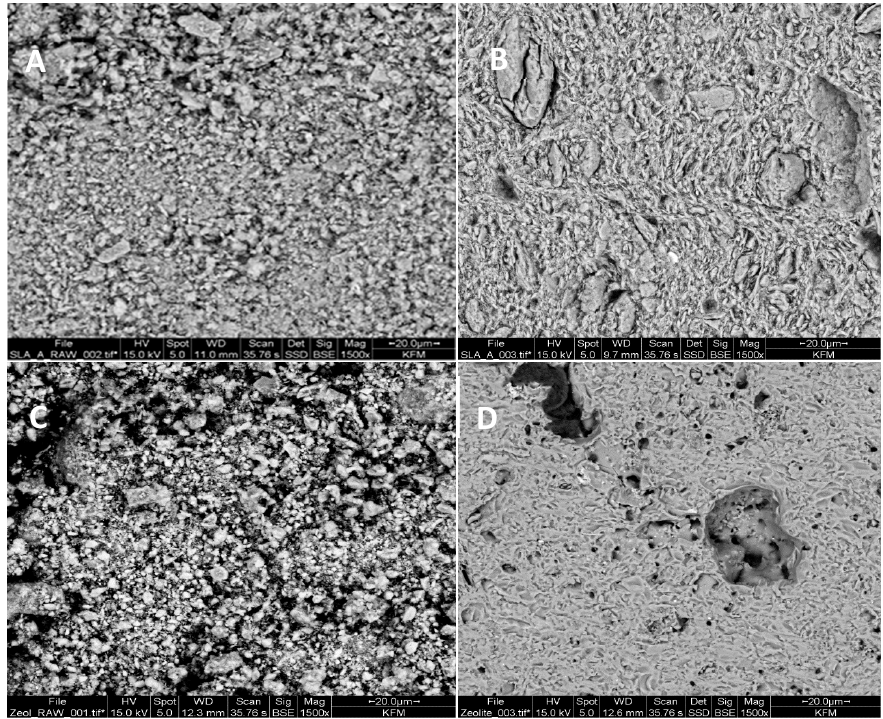
Figure 17. SEM pictures. ( A ) green Sedlec kaolin; ( B ) Sedlec kaolin fired at 1100 °C; ( C ) green zeolite; ( D ) zeolite fired at 1100 °C.